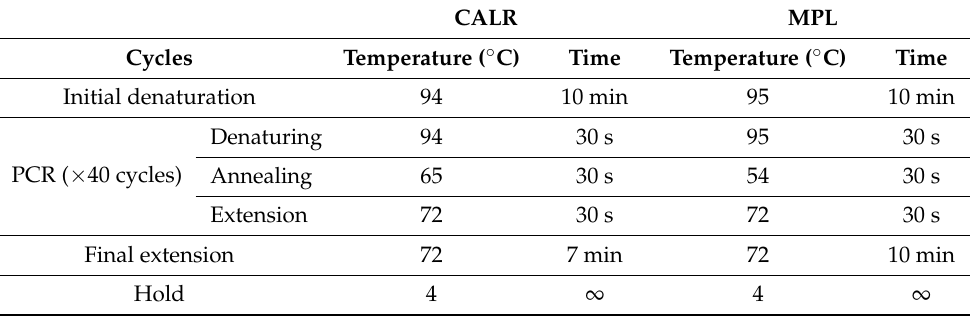
Table A3. PCR conditions for CALR and MPL.